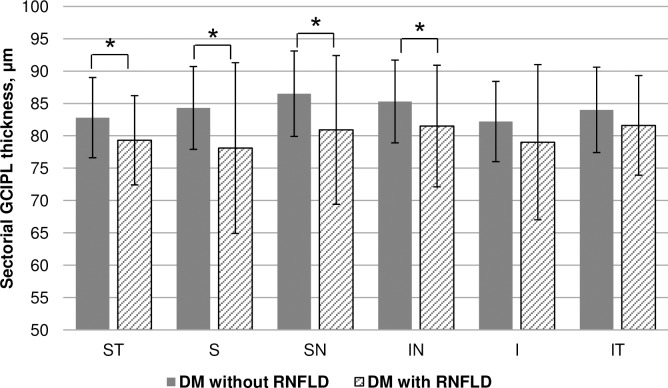
Comparisons of sectorial GCIPL thickness according to the presence of RNFL defect in diabetes.GCIPL ganglion cell-inner plexiform layer, RNFLD retinal nerve fiber layer defect, SN superonasal, S superior, ST superotemporal, IN inferonasal, I inferior, IT inferoteporal. *independent t-test.